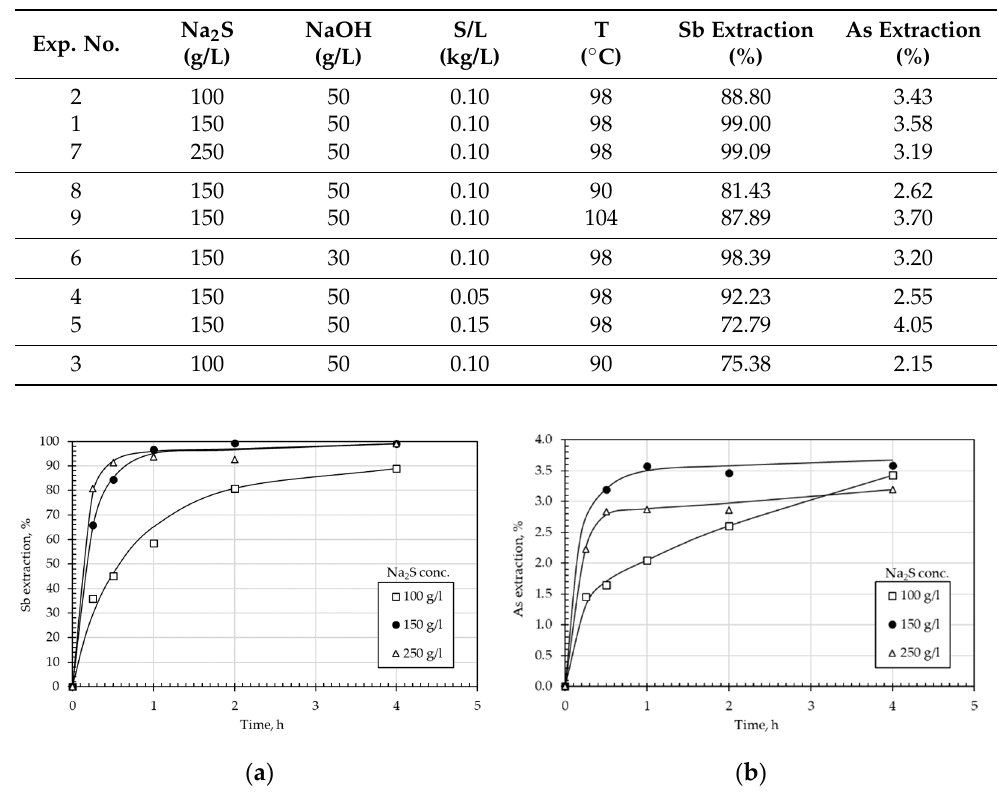
Figure 3. Extraction of ( a ) Sb and ( b ) As vs. time and Na 2 S concentration in the leaching solution (NaOH conc. 50 g/L, temperature 98 °C and S/L ratio 0.1 kg/L).